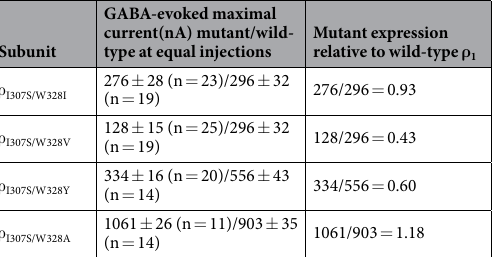
Table 4. The GABA-induced maximal current of key ρ 307/328 mutants (used in the mixing experiments) relative to that of ρ